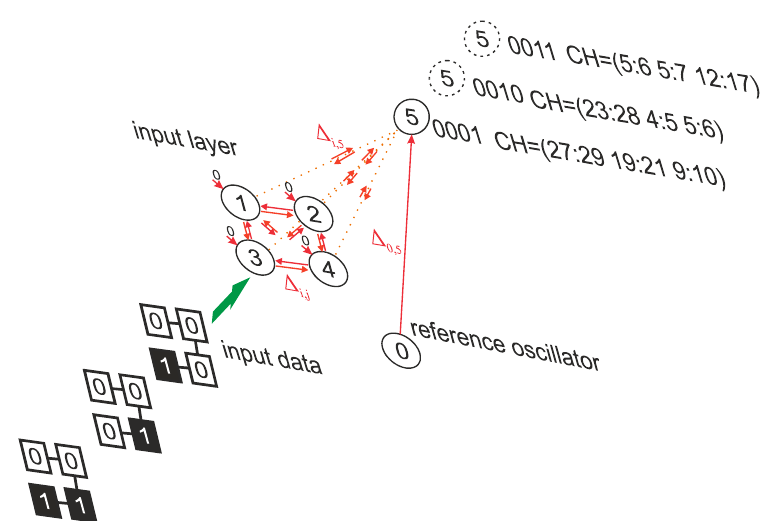
Figure 9. Model scheme of ONN with an example of converting binary numbers to CH values of the output oscillator’s synchronous state.